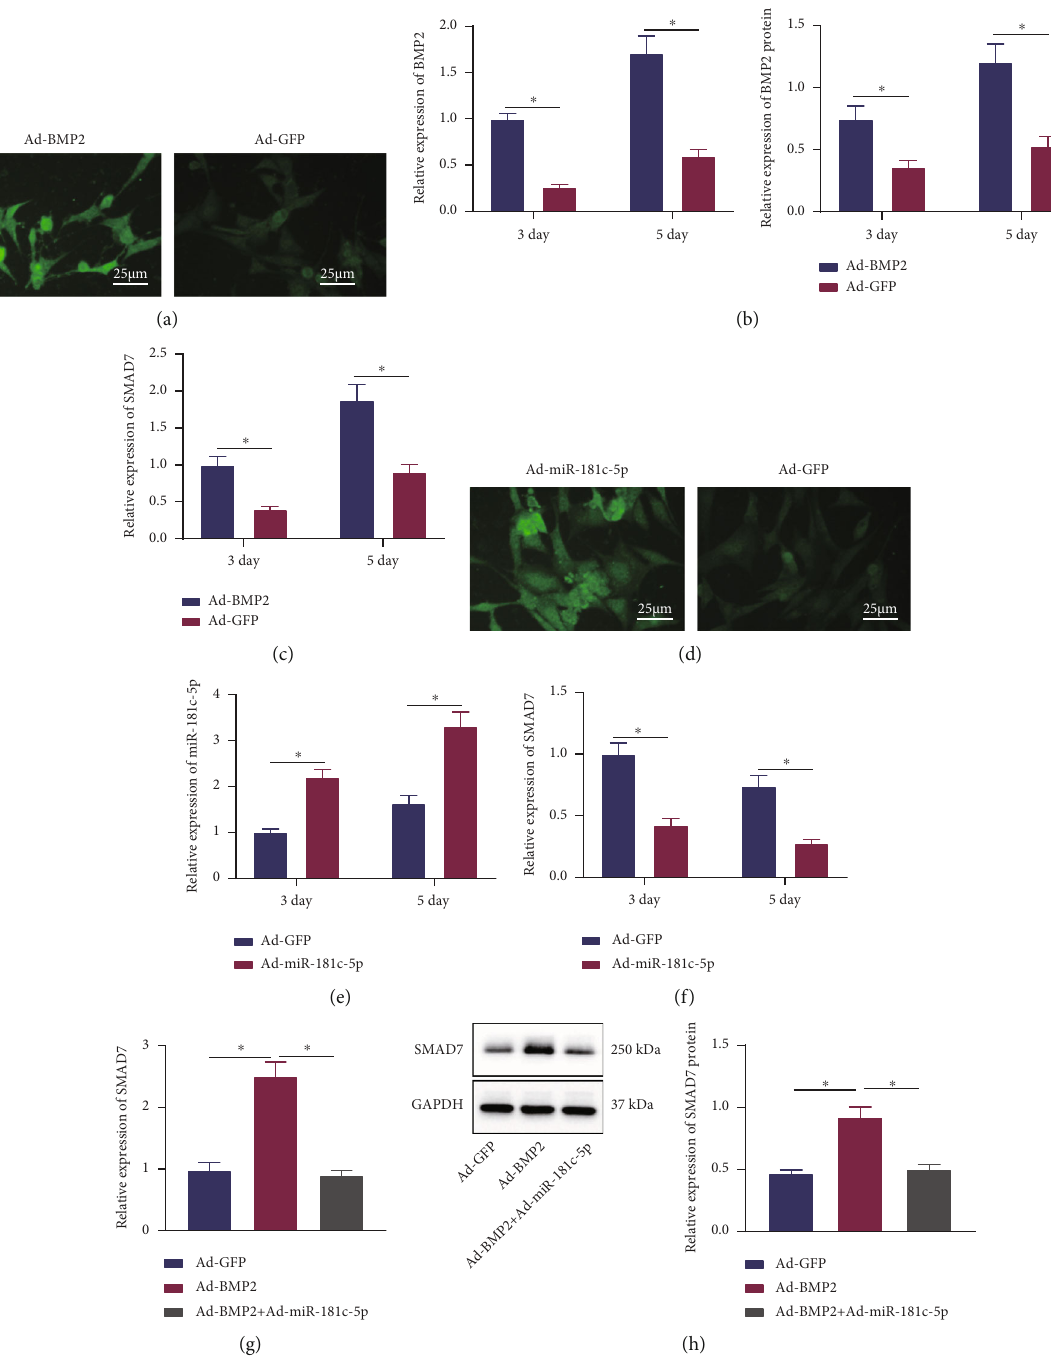
Figure 5: miR-181c-5p represses BMP2-induced SMAD7 expression. (a) Fluorescence microscopy observation of BMSCs after 3 days of infection with BMP2 overexpressing adenovirus ( scalebar = 25 μ m ). (b) BMP2 mRNA and protein levels in BMSCs after BMP2 overexpression determined by RT-qPCR and Western blot analysis. (c) SMAD7 mRNA level in BMSCs after BMP2 overexpression determined by RT-qPCR. (d) Fluorescence microscopy observation of BMSCs after 3 days of infection with miR-181c-5p adenovirus ( scale bar = 25 μ m ). (e) miR-181c-5p expression after overexpression of miR-181c-5p in BMSCs determined by RT-qPCR. (f) SMAD7 expression in BMSCs after overexpression of miR-181c-5p determined by RT-qPCR. (g) mRNA level of SMAD7 in BMSCs treated with Ad-BMP2 alone or combined with Ad-miR-181c-5p determined by RT-qPCR. (h) Protein level of SMAD7 in BMSCs treated with Ad- BMP2 alone or combined with Ad-miR-181c-5p measured by Western blot analysis. ∗ p < 0 : 05 . All experiments were repeated for three